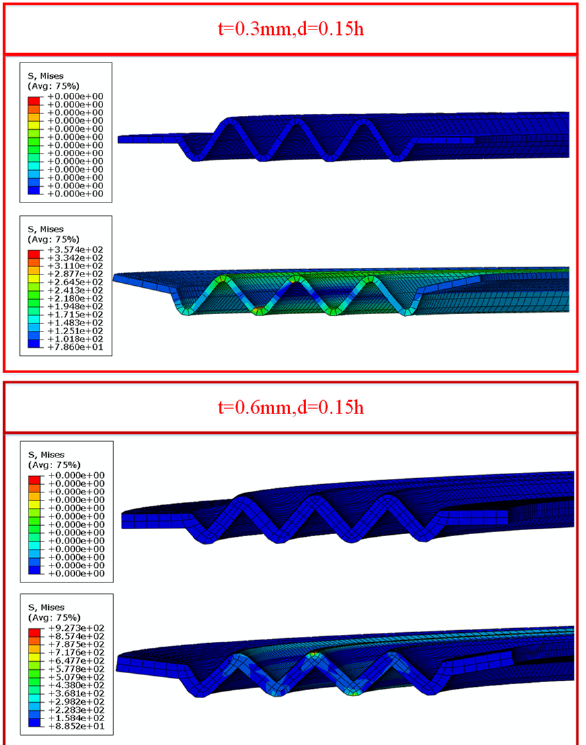
Figure 12. Deformation characteristics of NiTi alloy corrugated gasket with different plate thickness.